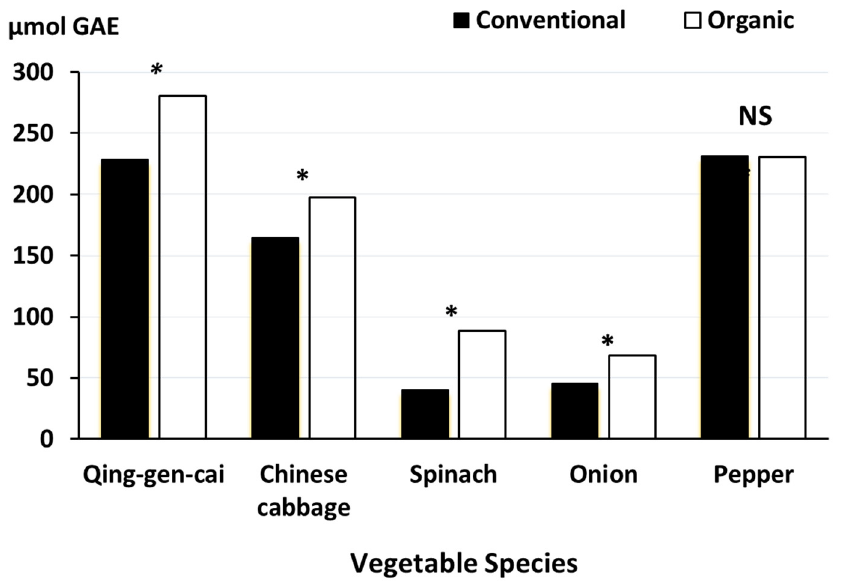
Figure 5. Effect of crop management (organic vs conventional) on antioxidant activity/capacity in vegetables. GAE, gallic acid equivalents data from [91]. The organic (but not the conventional) crop management included the incorporation of 500 kg chitosan/ha before planting, and crops being sprayed regularly with a 0.01% chitosan solution during the growing season. *, significant difference ( p < 0.05); NS, not significant.